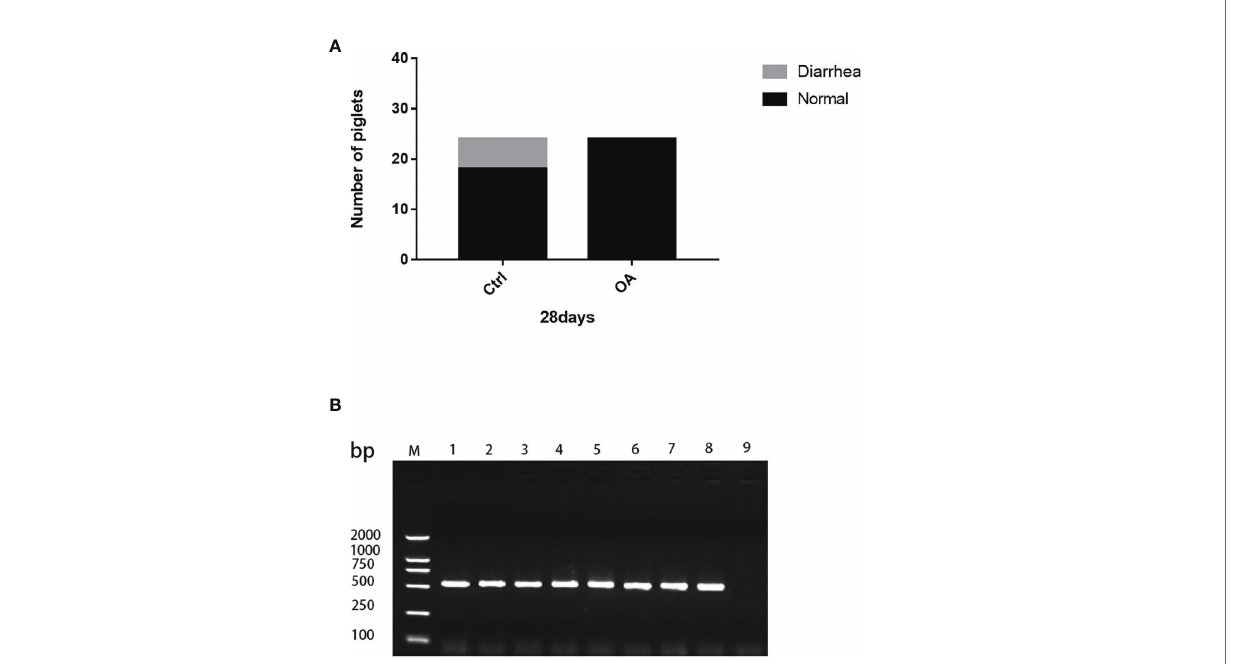
FIGURE 2 | The diarrhea occurring rate in piglets (A) . PCR identi fi cation of diarrhea samples (B) . The diarrhea rate in the control group was 25%, but that in the treatment group did not occur (A) . Lanes 1 – 6, PCR templates from diarrhea piglet feces; Lane 7, r L.casei plasmid template as positive control; Lane 8, ETEC K88 as positive control; Lane 9, negative control. The ETEC K88 gene was ampli fi ed by PCR, suggesting that the symptoms of piglets ’ diarrhea were caused by ETEC K88 (B)